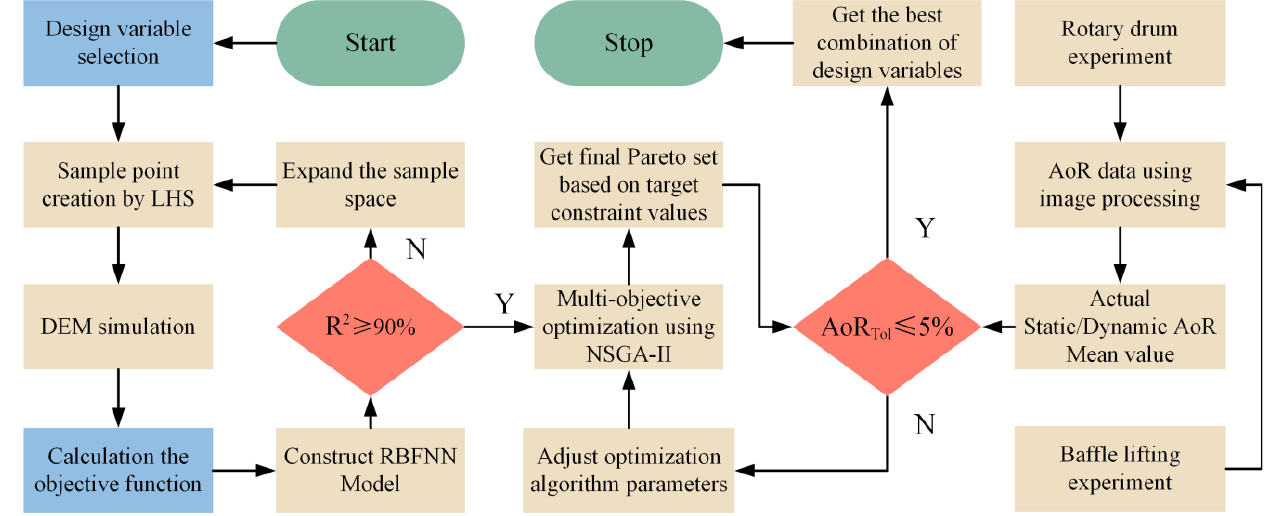
Figure 9. Flow chart of multi-objective optimization.